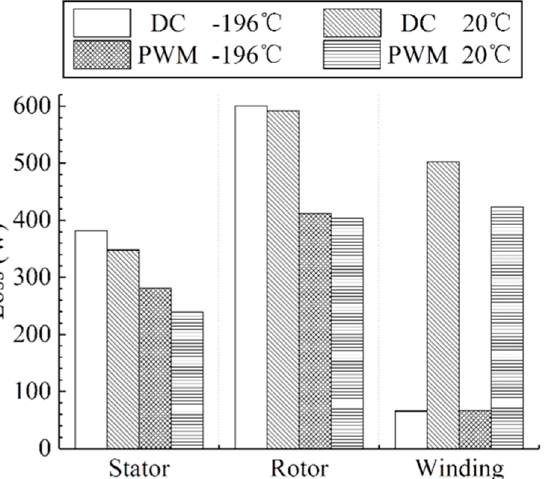
Figure 11. Comparison diagram of motor loss under different power-supply modes and different temperatures.